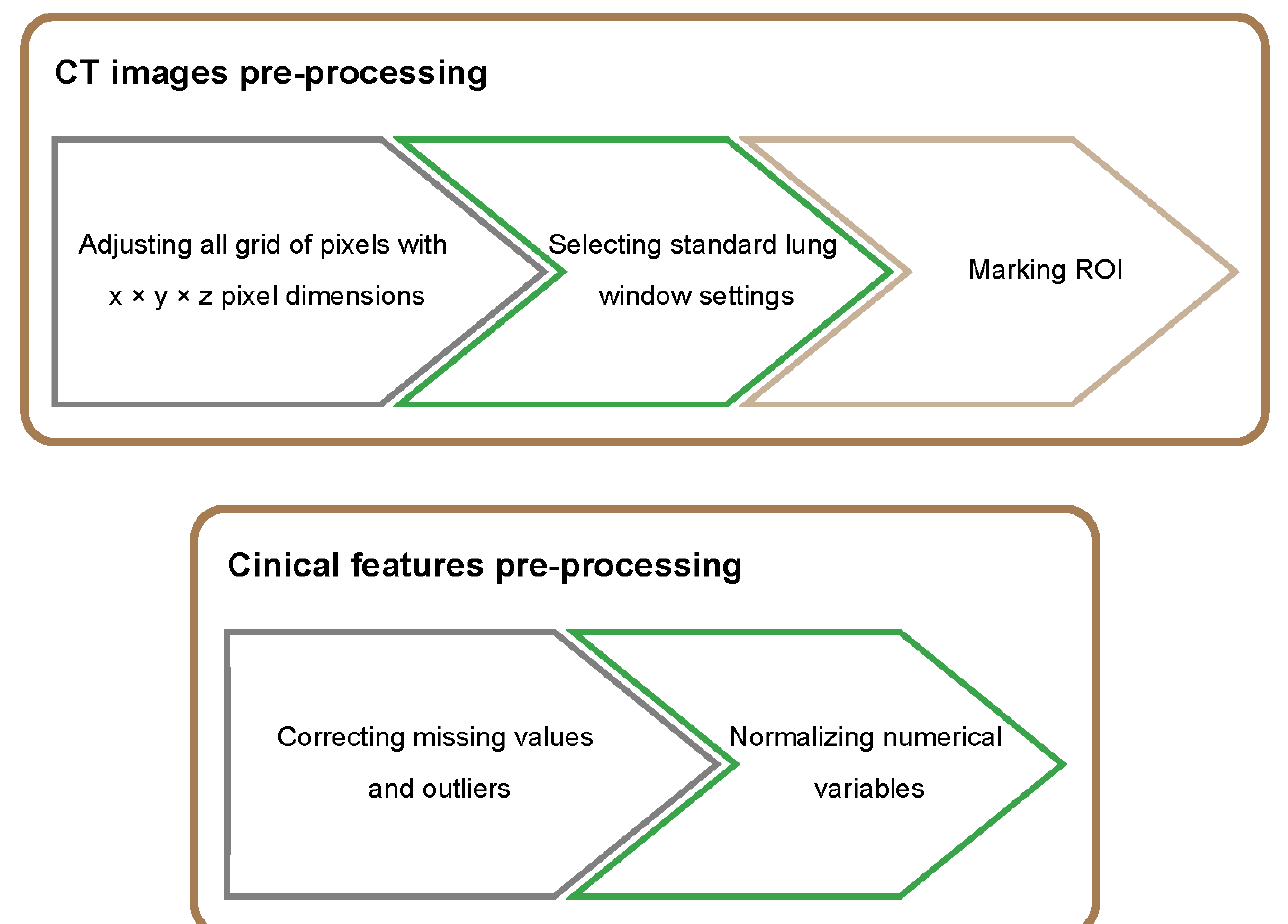
Figure 2. The workflow of data pre ‐ processing.